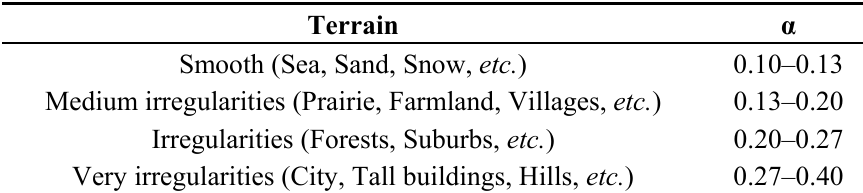
Table 1. Variation of α empirical values with